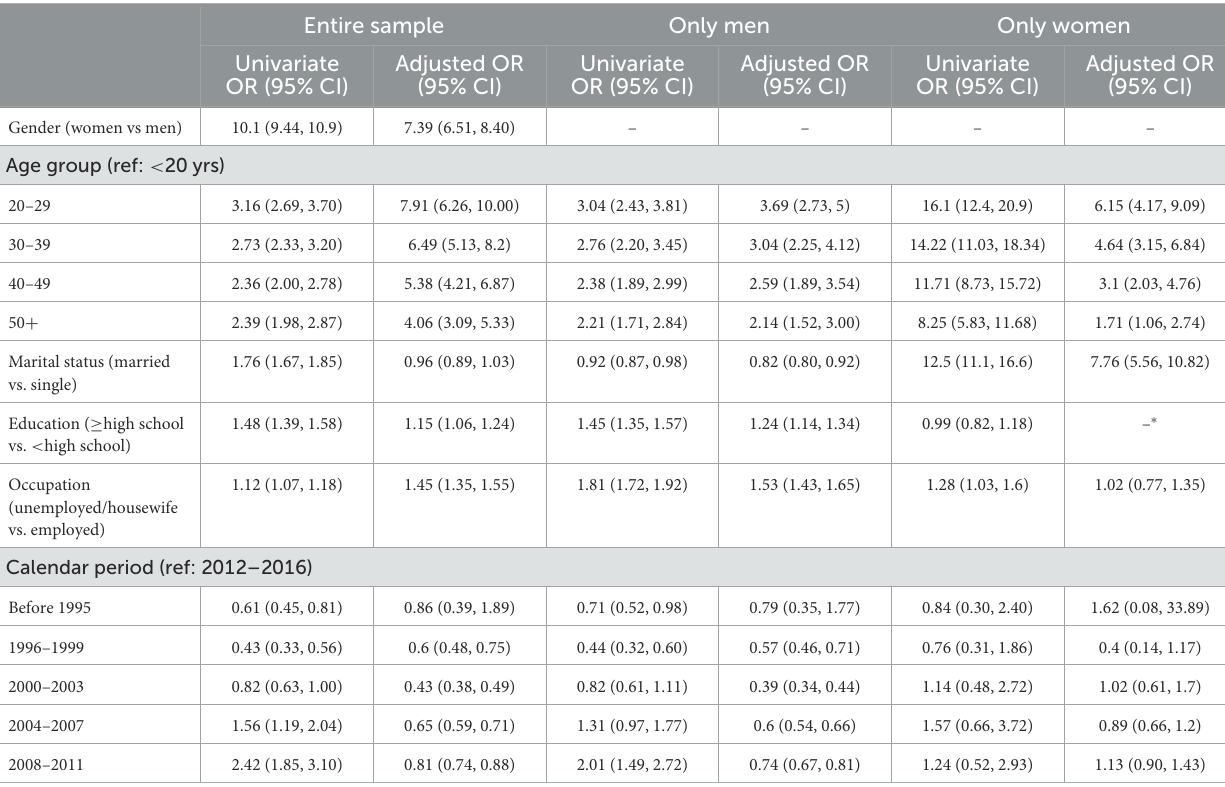
TABLE 4 Socio-demographic and background characteristics associated with the acquisition of HIV through sexual transmission route in the entire